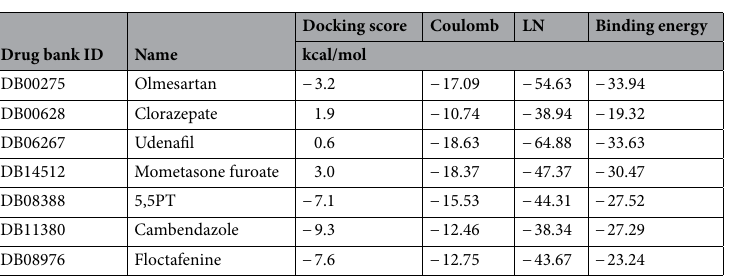
Figure 12. Chemical structure of the best molecules derived from the drug bank screening.